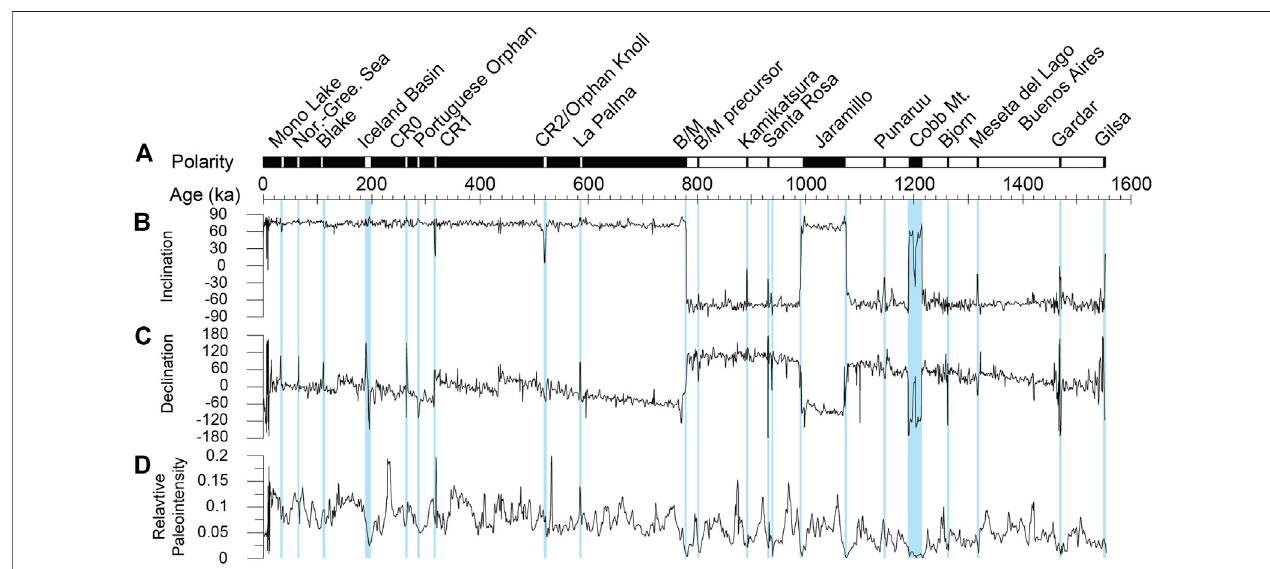
FIGURE 2 | Temporal variation trends of (A) magnetostratigraphy, (B) inclination, (C) declination and (D) relative paleointensity of core MD01-2414. The new age model is based on Lo et al. (2018). Field reversal and geomagnetic excursion events were marked by blue bars.